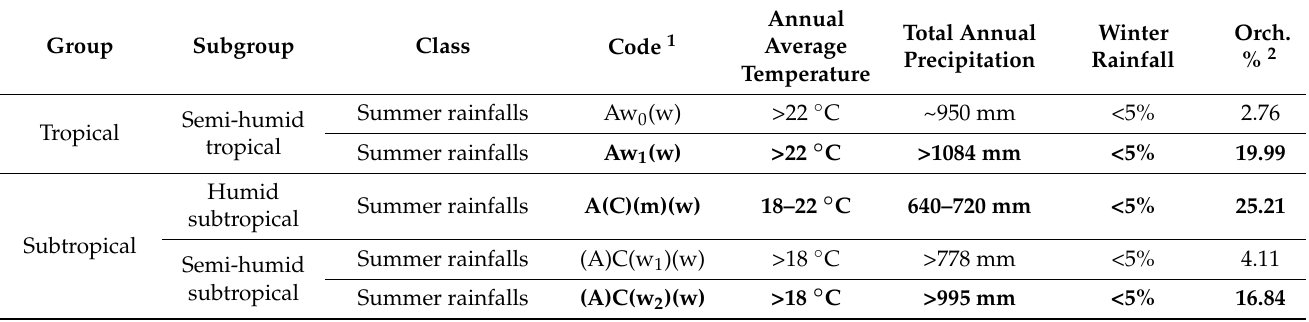
Table A1. Atmospheric summary of the Michoacan Avocado